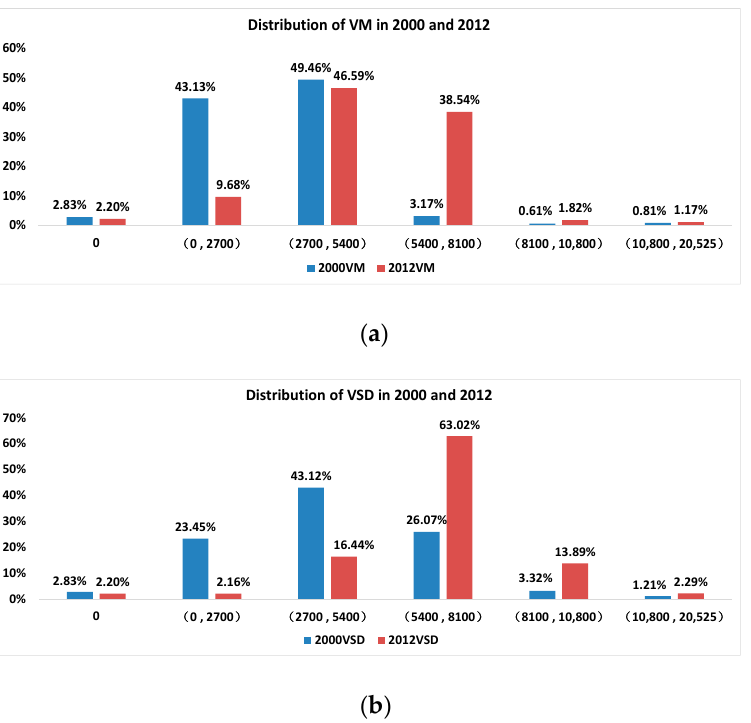
Figure 8. Interval distribution of VM and VSD in 2000 and 2012: ( a ) VM; ( b ) VSD. (Note: VM = volume mean, VSD = Volume Standard Deviation).